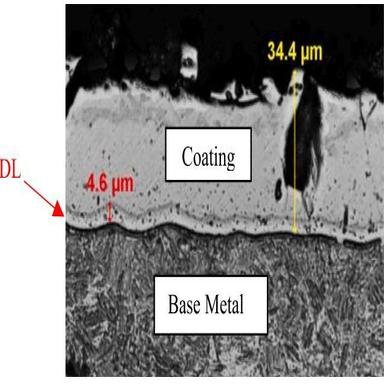
Microscopy image of IDL in between base metal and coating.